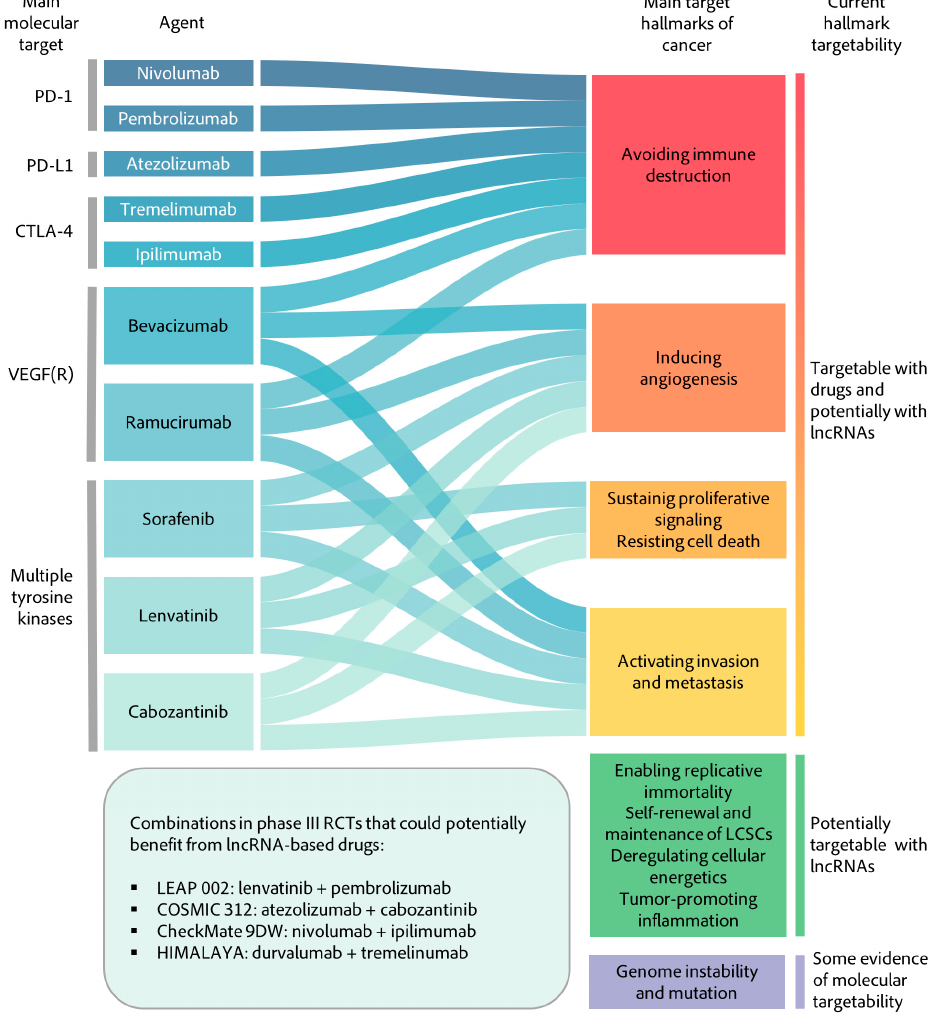
Figure 5. Sankey diagram of suggested combination therapies. Approved drugs for HCC and their main molecular targets are shown to the left and linked to their main cancer hallmark and the hallmark druggability, including those based on potential lncRNA targeting. The box at the bottom shows ongoing Phase III clinical trials that could also benefit from lncRNA therapy.